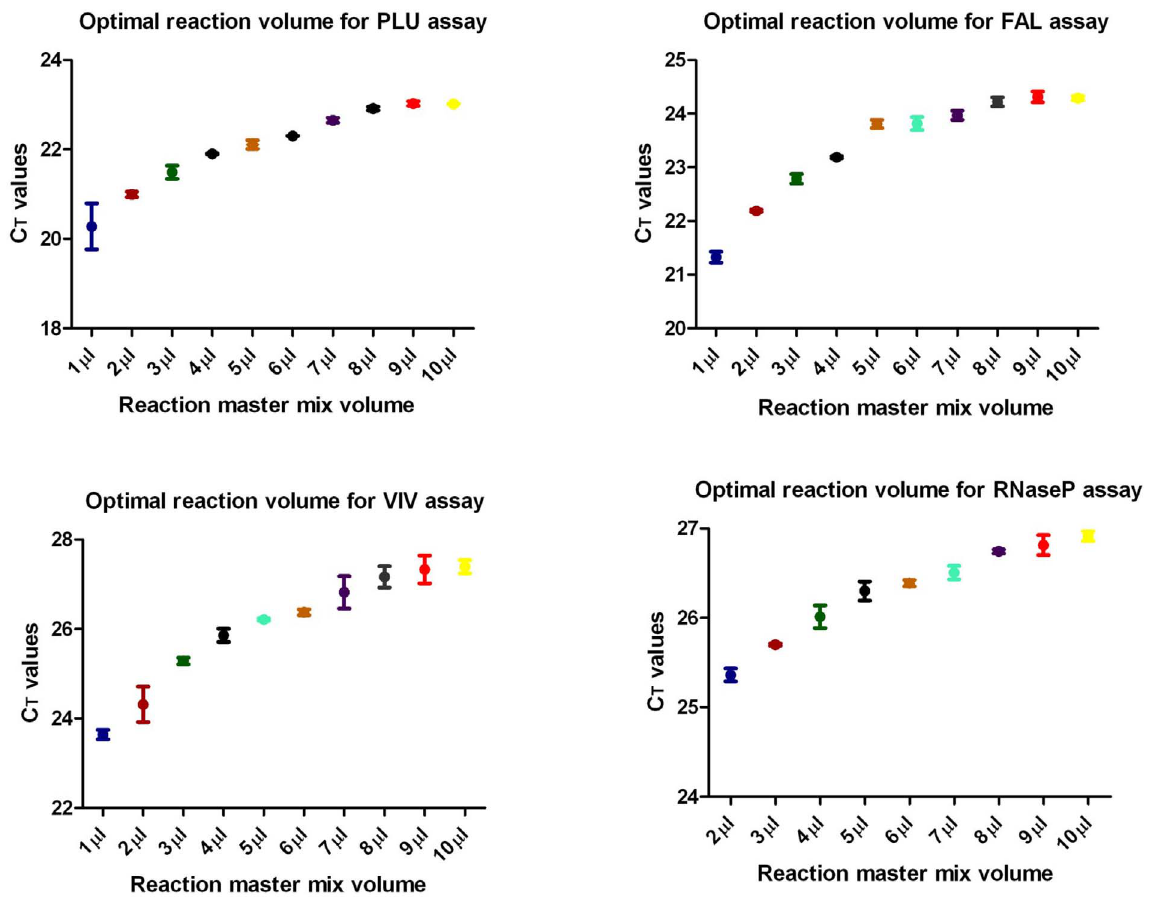
Figure 1. Titration of reaction master mix volume in qPCR reaction. Multiplex qPCR reactions were set-up that contained descending reaction master mix from 10 m l to 1 m l and 1 m l DNA template in each reaction. Experiments were performed in total replicates of 8. All the four targets in the multiplex qPCR assay were analyzed simultaneously. There was a negative correlation between reaction master mix volume and assay sensitivity. As the volume of reaction master mix increased, the sensitivity of the qPCR decreased with 1 m l reaction master mix reaction being the most sensitive for PLU, FAL and VIV assays.